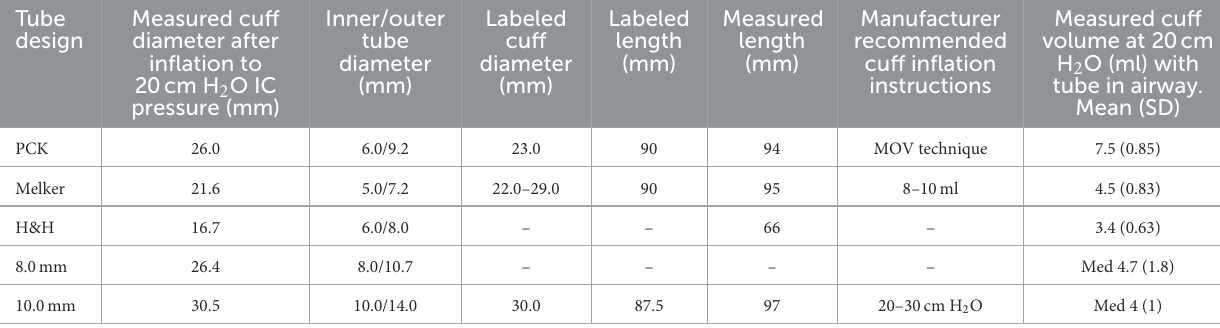
TABLE 1 Tube characteristics for the five tubes placed via cricothyrotomy in 10 cadaver dogs.